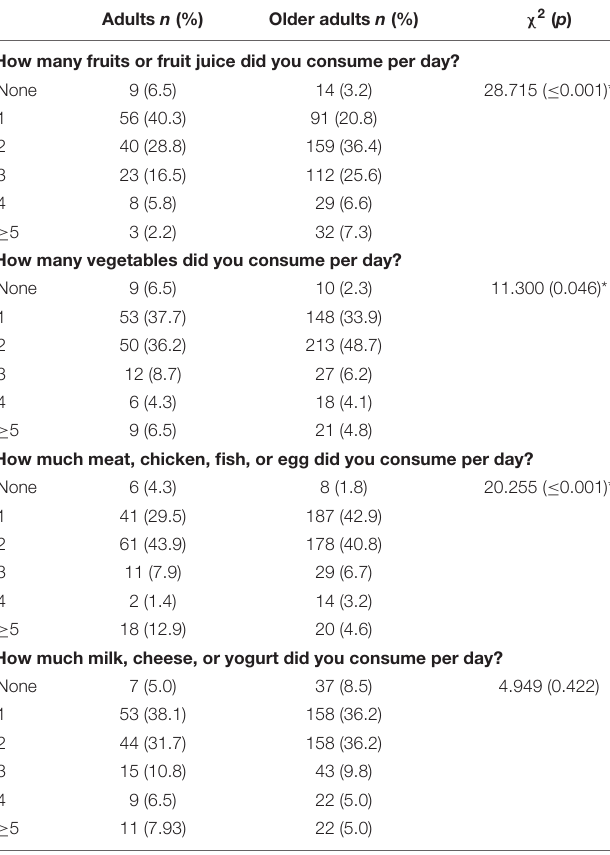
TABLE 5 | Perception of the emotional status for adults ( n = 139) and older adults ( n = 437) during social distancing due to the COVID-19 pandemic. χ 2 ( p ) Adults n Older adults n (%) (%) What is the closest point of your feeling in the last 15